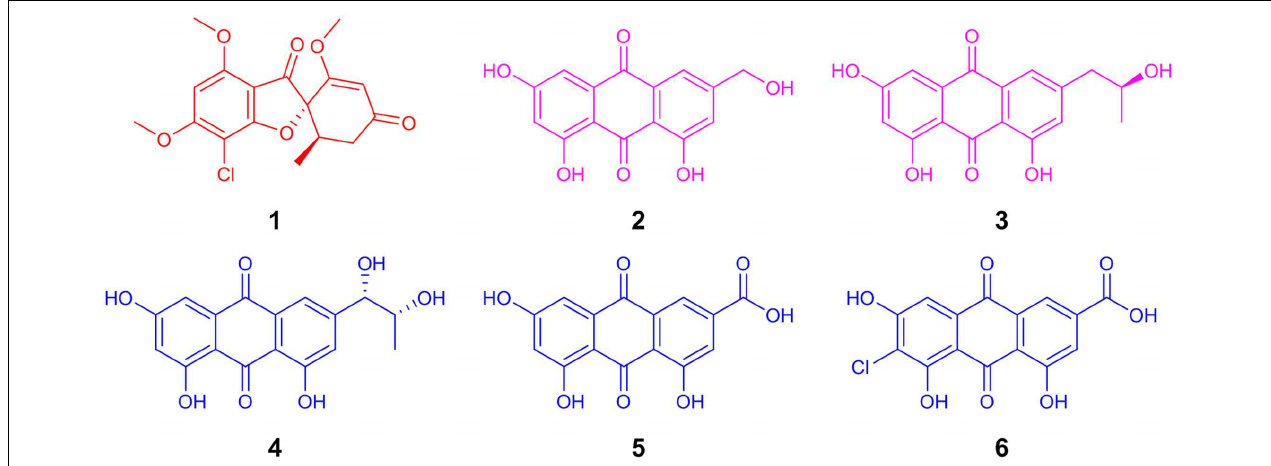
FIGURE 1 | The structure of the antifungal agent, griseofulvin (1; red), from Xylaria cubensis (G536). The polyhydroxyanthraquinones (2–6) from Penicillium restrictum (G85) were grouped into two categories (purple and blue) based on their distributions in